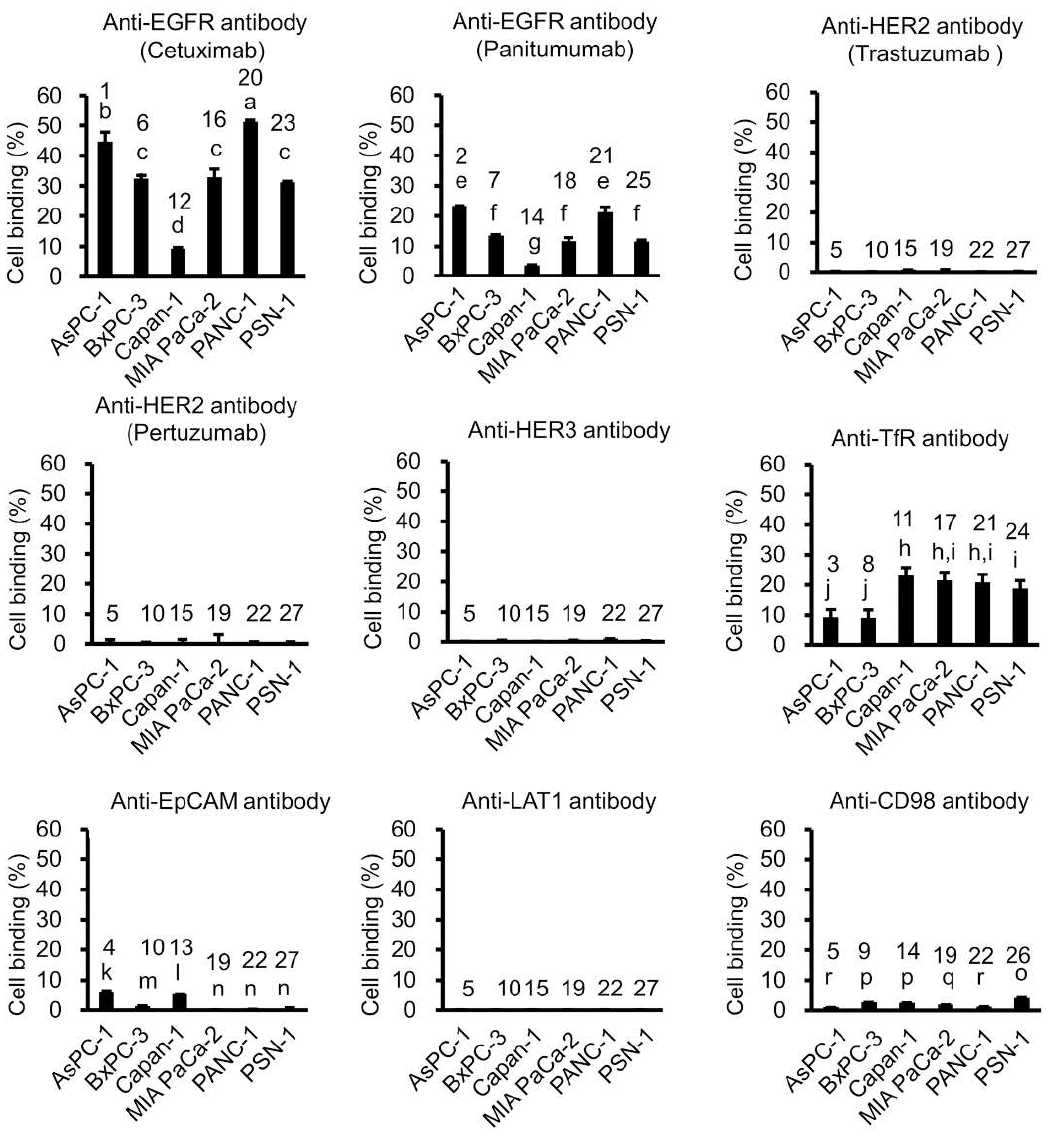
Figure 2. In vitro tumor cell-binding assay with 64 Cu-labeled antibodies. Cell binding (%) for nine candidate 64 Cu-labeled antibodies, including 64 Cu-anti-EGFR antibodies (cetuximab and panitumumab), anti-HER2 antibodies (trastuzumab and pertuzumab), anti-HER3, anti-TfR, anti-EpCAM, anti-LAT1, and anti-CD98 antibodies in six human pancreatic cancer cell lines (AsPC-1, BxPC-3, Capan-1, MIA PaCa-2, PANC-1, and PSN-1). There were significant differences between different characters in a–c; e–g; h–j; k–n; o–r, among antibodies; 1–5; 6–10; 11–15; 16–19; 20–22; 23–27, and among the cell lines, respectively ( p < 0.05).